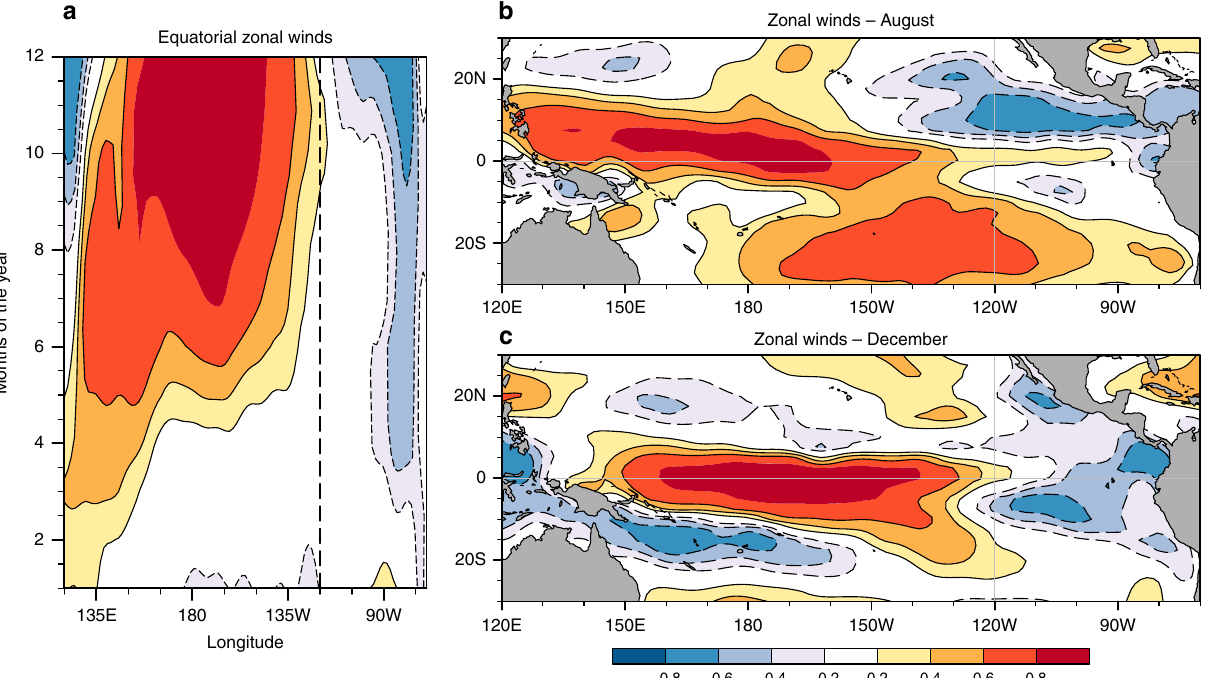
Fig. 2 The structure of zonal wind anomalies associated with El Niño. a The correlation between boreal winter Nino3.4 SST index and monthly equatorial (averaged over 5°S to 5°N) zonal wind anomalies. Panels b and c are the same, but here the Nino3.4 index was correlated with wind anomalies during August and December, respectively. Monthly data from 1958 to 2015 were used in the calculation. These were pre-processed by removing decadal anomalies with periods longer than 7 years. Then, a 5-month running mean was used to smooth the data of high-frequency variations. Data during all months of 1972, 1982, and 1997 were excluded from the analysis. The maps in the fi gure were rendered with the NCAR Command Language